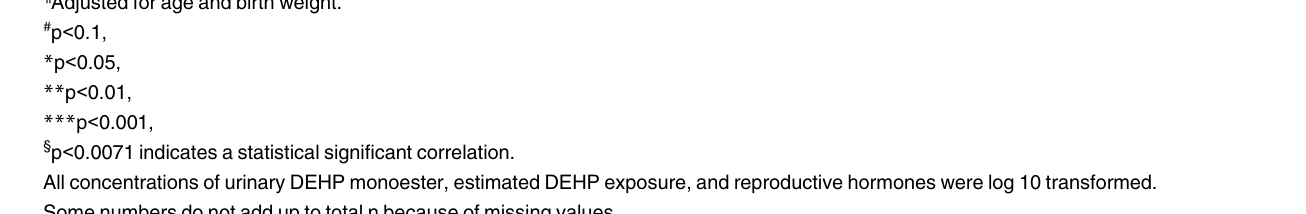
Estimated DEHP exposure levels ( μ g/kg bw/day) (n =